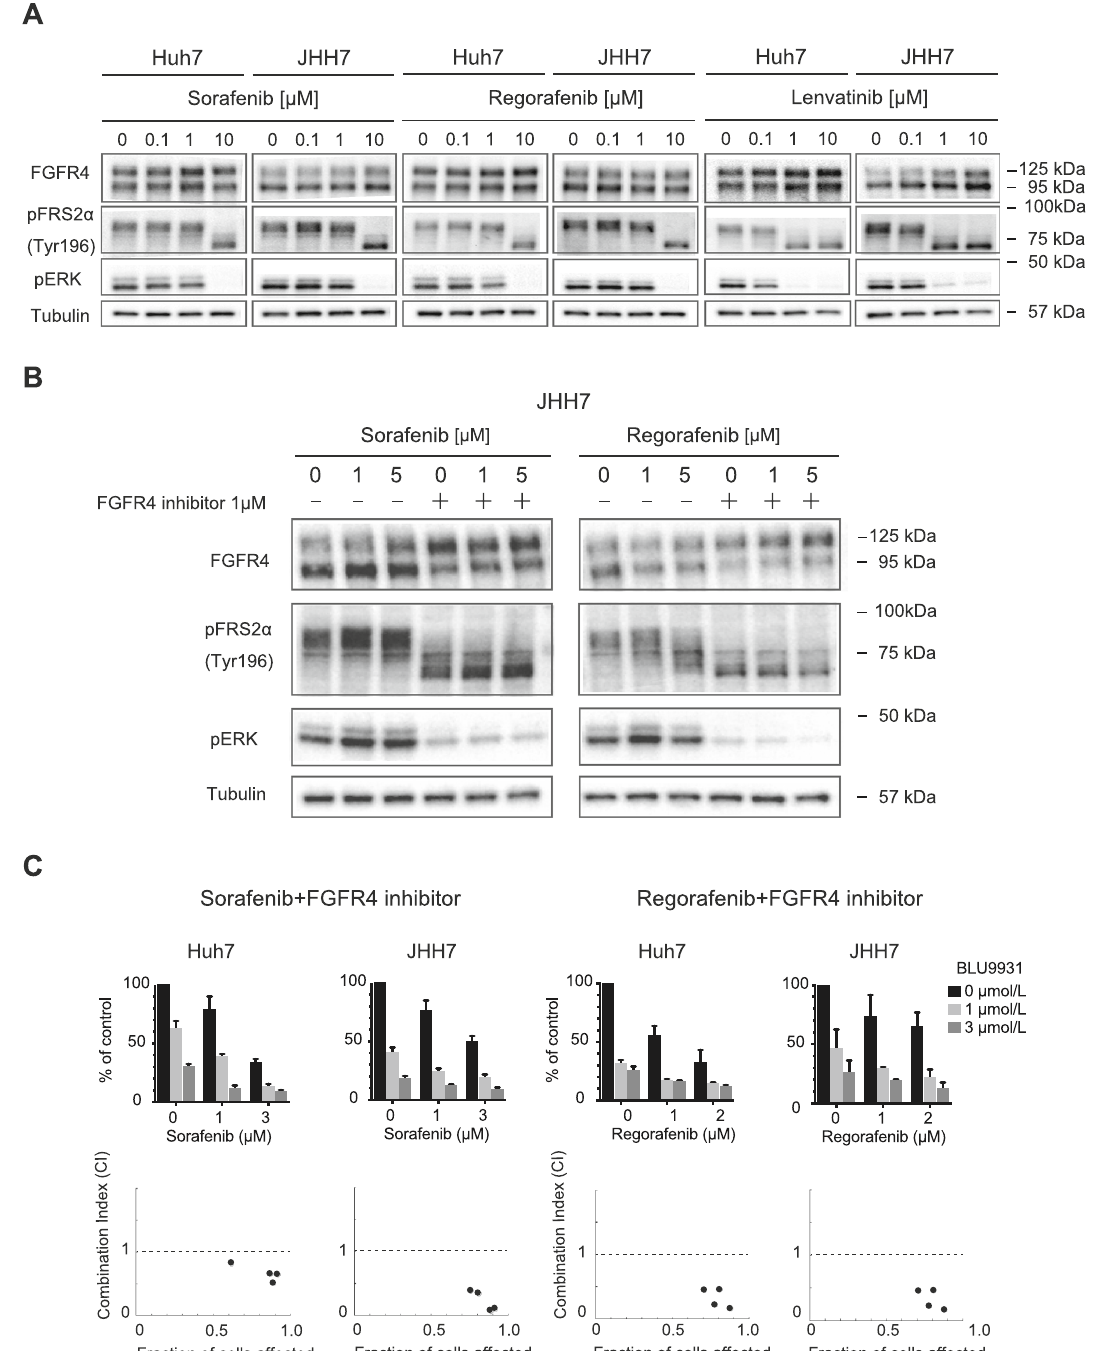
Figure 3. FGFR4/ERK signaling inhibition in HCC cells treated with MKIs and a FGFR4 selective inhibitor. ( A , B ) Cells treated with MKIs ( A ), and co-treated with MKIs and BLU-9931, a FGFR4 selective inhibitor ( B ), were subjected to Western blot analyses using anti-FGFR4, anti-pFRS2α, anti-pERK and anti-tubulin (loading control) antibodies. ( C ) Synergistic inhibitory effects of MKIs and FGFR4 selective inhibitor on HCC cell proliferation 120 h after seeding. These data were from three independent experiments. The combination index (CI) is shown below each